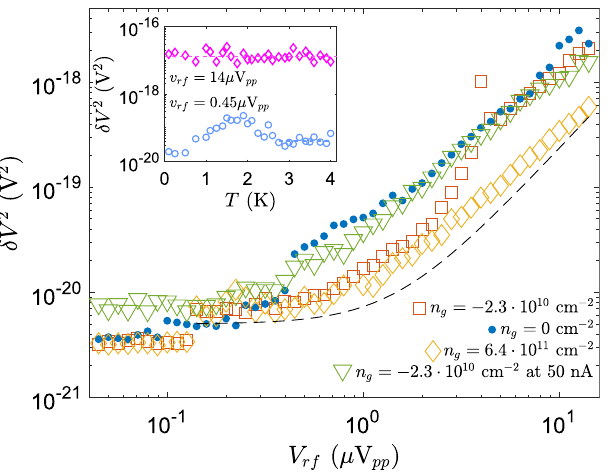
2 Figure 5. Noise power δ V using 13.1 mHz frequency bin at 0.1 Hz, taken from fitted curves illustrated in Fig. 3, as a function of carrier amplitude v rf for a few values of n g indicated in the figure. At 2 2.3 10 10 cm n g we present also data with a DC bias current 50 nA > I c which forces the sample − = − × to normal state. The measurement gate voltage values are marked with respective color bullets on the normal state resistance versus carrier density plot, displayed in Fig. 1. The black dashed curve, representing a b V 2 rf , is a guide for the eyes. Inset: Change of noise power + 2 2.3 10 10 cm n g . Thermally induced phase diffusion in the variable ϕ is seen as a bump in δ V − = − × 2 0.45 µ V measured at V pp rf =